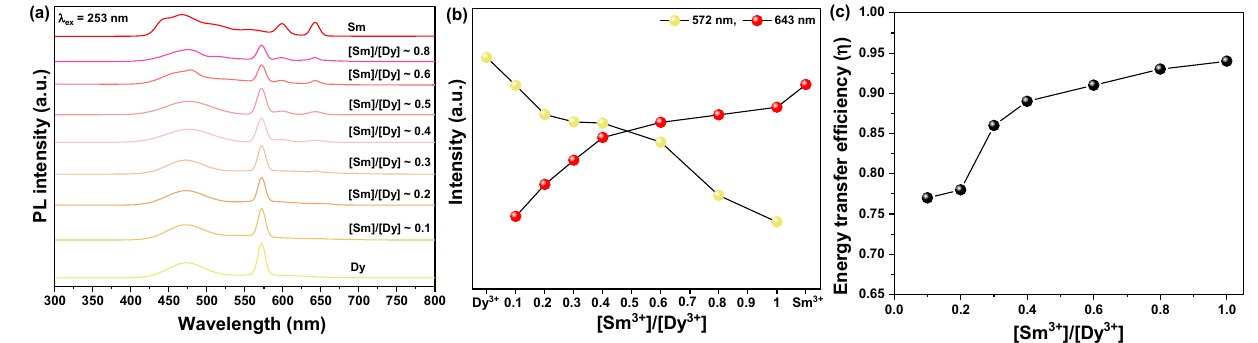
Figure 7. ( a ) PL spectra of SrWO 4 :[Sm 3+ ]/[Dy 3+ ] under 253 nm, ( b ) change in PL intensity at 572 nm and 643 nm, and ( c ) energy transfer efficiency.